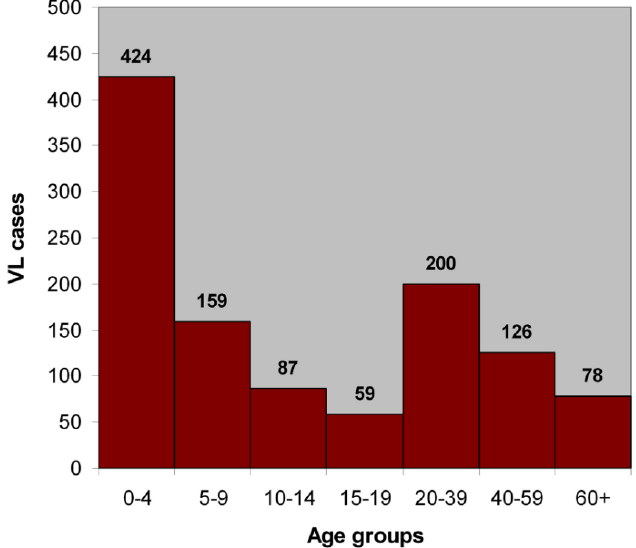
Figure 4. Age distribution of visceral leishmaniasis in Attica, Greece 1961–2004.